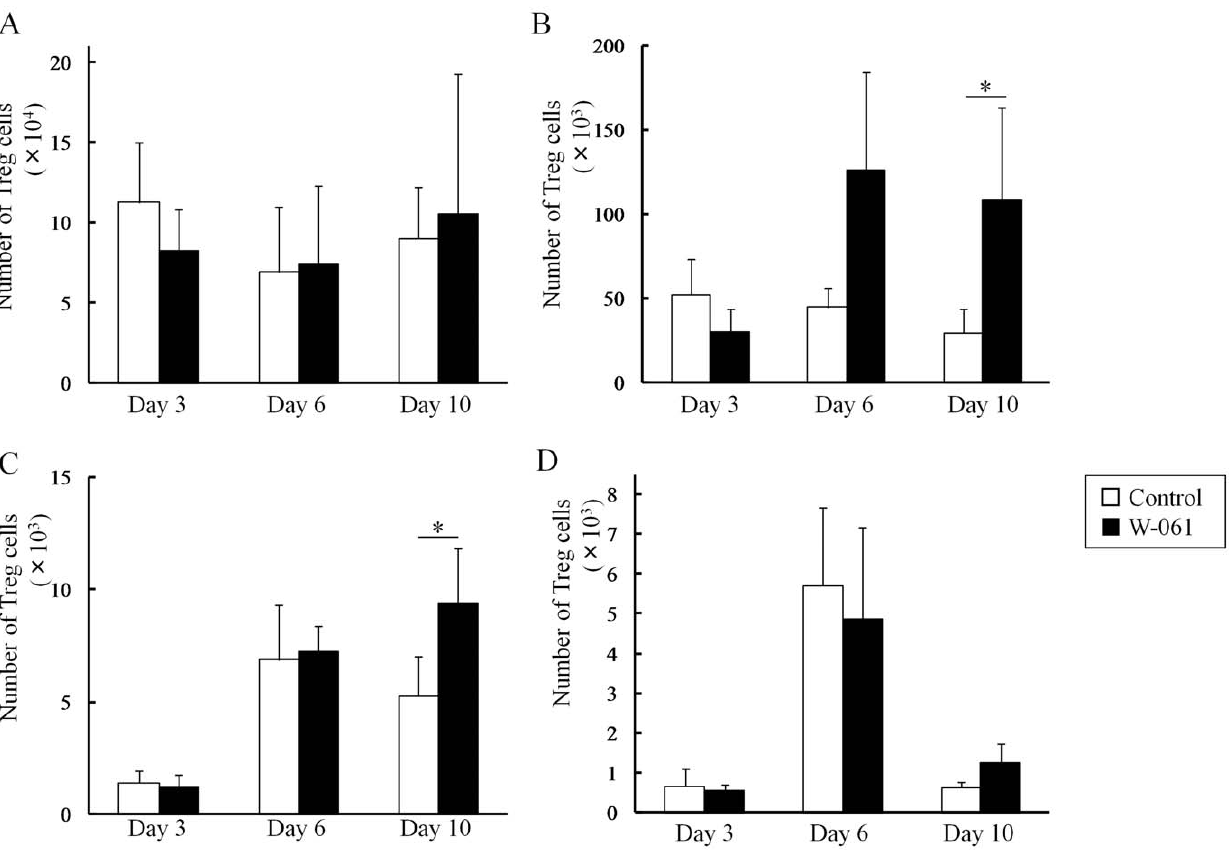
Figure 5. Change of the numbers of Treg cells in (A) SP, (B) MLN, (C) PP and (D) LP. Data represent absolute values (means 6 SD, n=4 per group on days 3 and 6, n=6 per group on day 10, * p ,